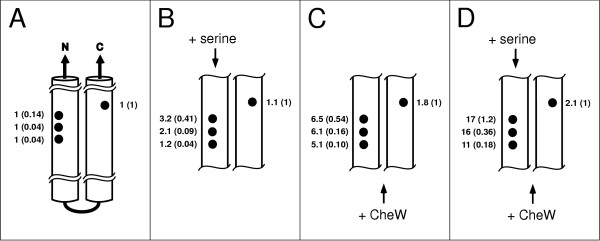
The influences of serine and CheW on methylation. The enlarged representation of the methylation region from one Tsr subunit in panel A illustrates the locations relative to the N and C-termini of Tsr (N and C), and the cytoplasmic domain hairpin (at bottom). For simplicity, all other representations depict (panels B to D) show only the two methylation helices. Numbers next to the four sites are relative rates (r); not in parentheses are rates relative to the rate without ligand (r = v+ligand(s)/vno ligand). The r-values in parentheses are the rates at various sites (vn) relative to the rate at site four (v4) under the same conditions (r = vn/v4). A: no ligand;B: 500 μM serine; C: 60 μM CheW; D: both serine and CheW.